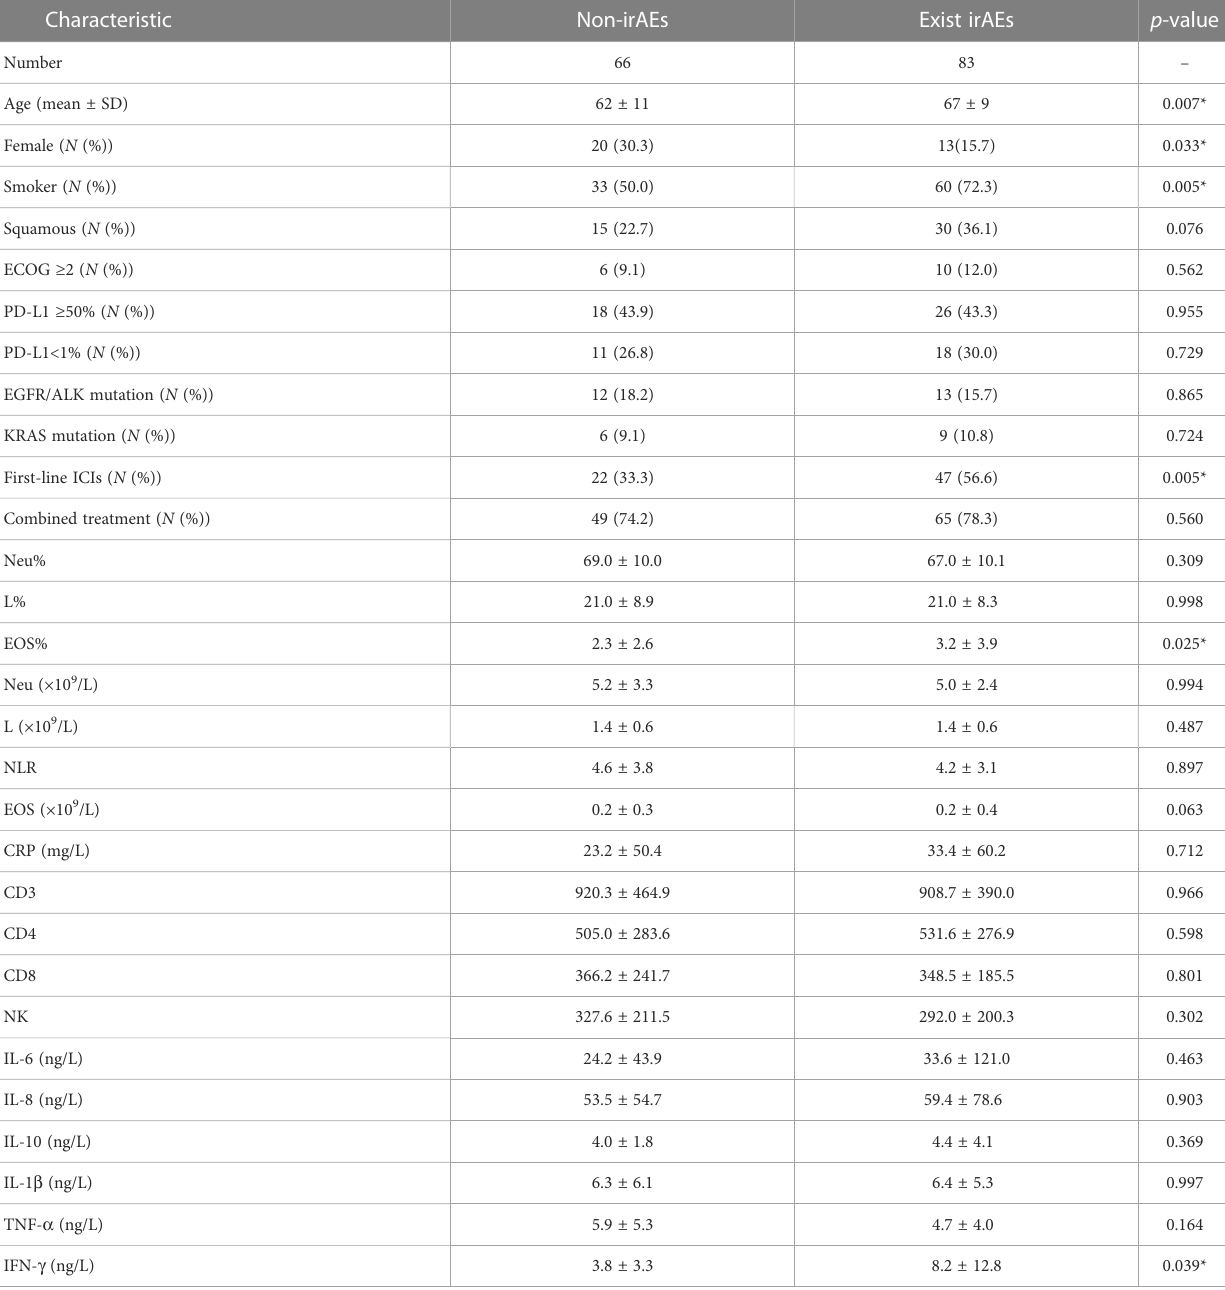
TABLE 4 Characteristics of patients between whether exist irAEs. Characteristic